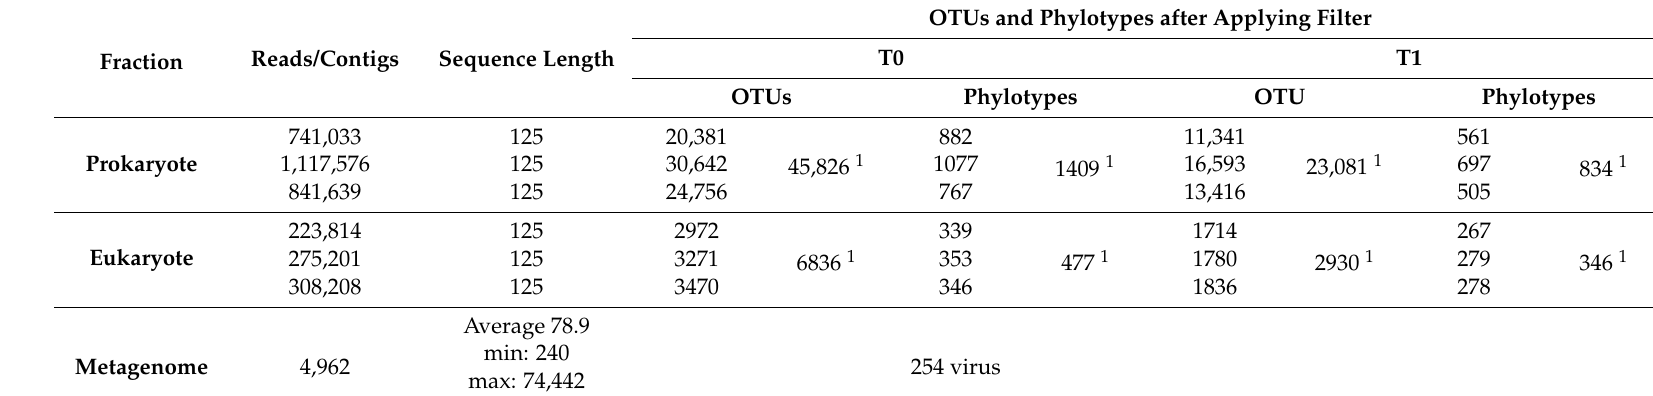
Table 1. Description of sequences generated in this